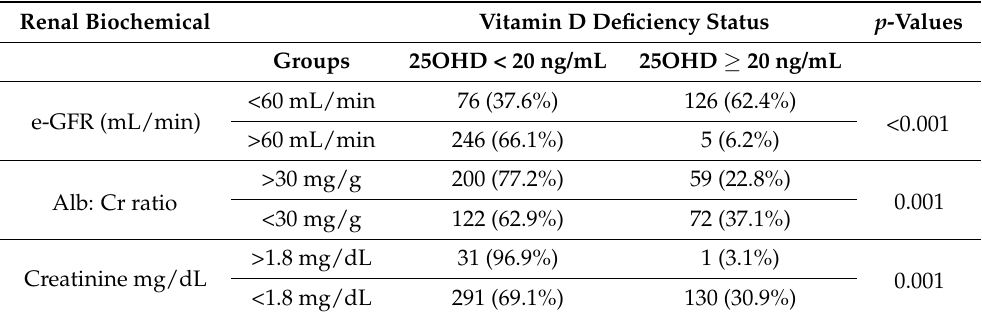
Table 2. Renal biochemical markers according to vitamin D deficiency. Renal Biochemical Vitamin D Deficiency Status p -Values